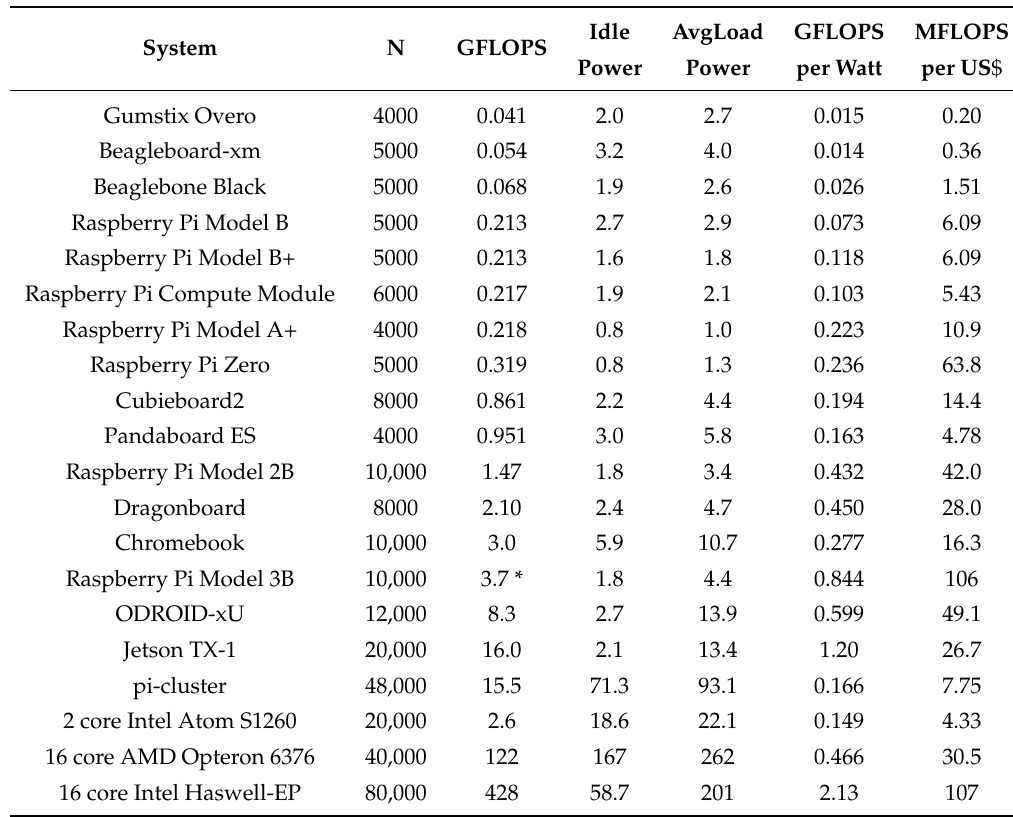
Table 2. Performance (FLOPS) and power summary for the various ARM boards, with three x86 systems shown for comparison. Many runs were done, with the peak FLOPS result (as well as the corresponding high-performance Linpack (HPL) benchmark N matrix size parameter) reported. Some of the high-end ARM boards compare favorably with the x86 systems on the GFLOPS per Watt and MFLOPS per US dollar